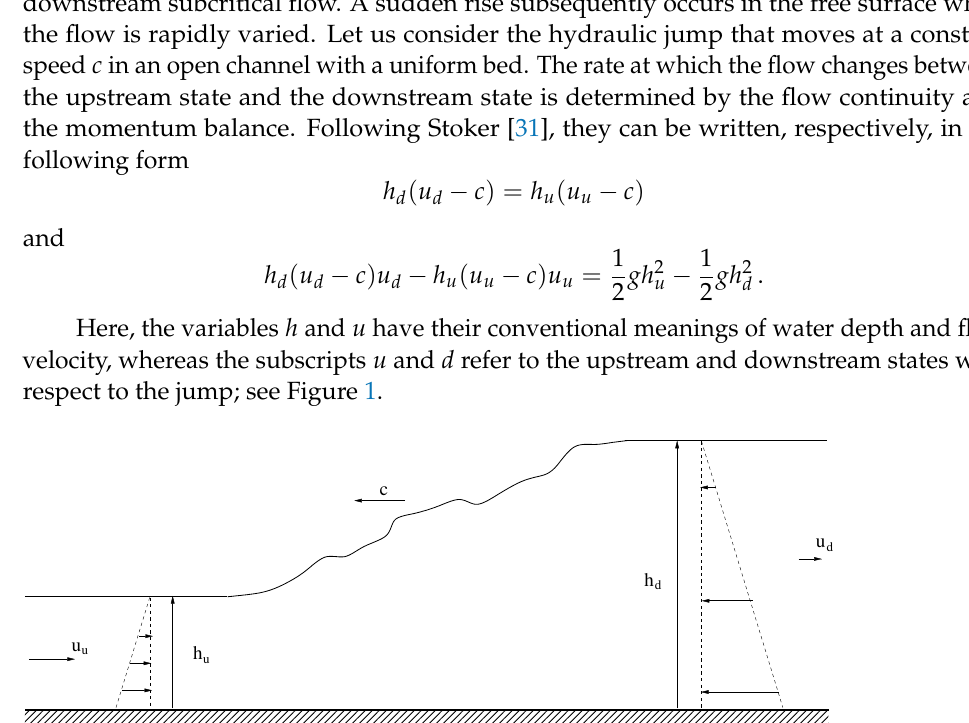
Figure 1. The hydraulic jump. The flow velocities are relative to the bed. The distribution of hydrostatic pressure is shown upstream and downstream of the jump. Definitions of the variables are provided in the